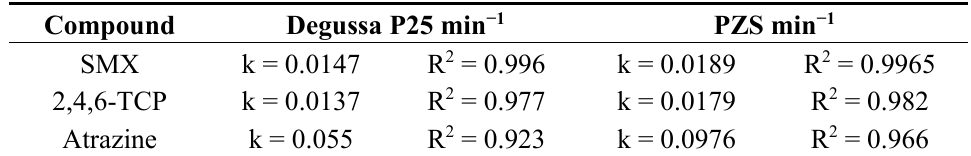
Table 2. Pseudo first order rate constants (min − 1 ) and R 2 fit measure for the